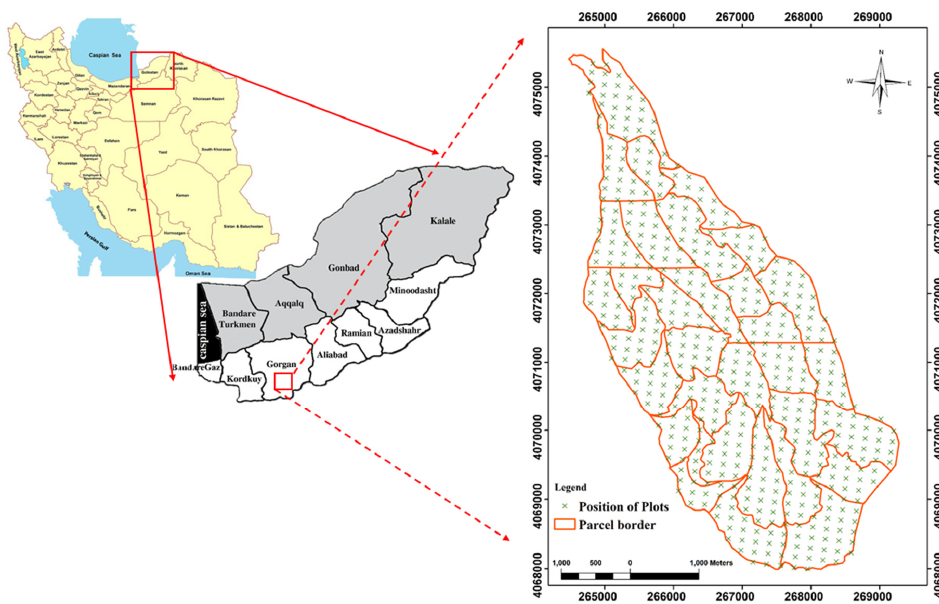
Figure 1. Location of the research area in Dr. Bahramnia’s forestry district, Golestan province in northern Iran.